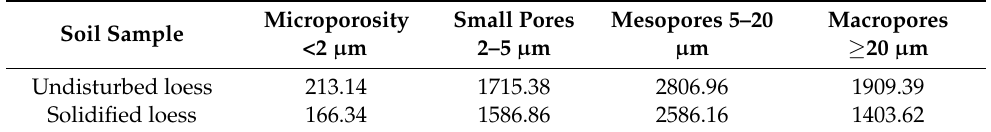
Figure 7. Picture of undisturbed loess after binarization. Table 3. Areas of different types of pores ( µ m 2 ). Table 3. Areas of different types of pores ( μ m 2 ).